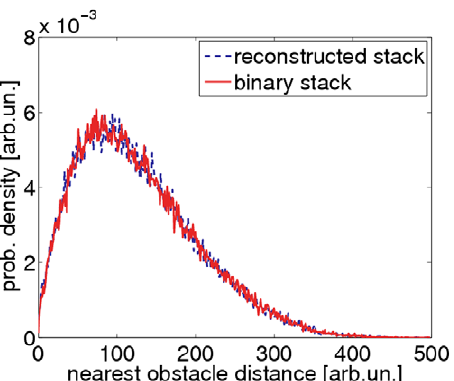
Figure 10. Statistical test of reconstruction quality. We determined the distributions of nearest obstacle distances in a binary surrogate data set and the corresponding reconstruction result. Both distributions are identical, disregarding statistical fluctuations.